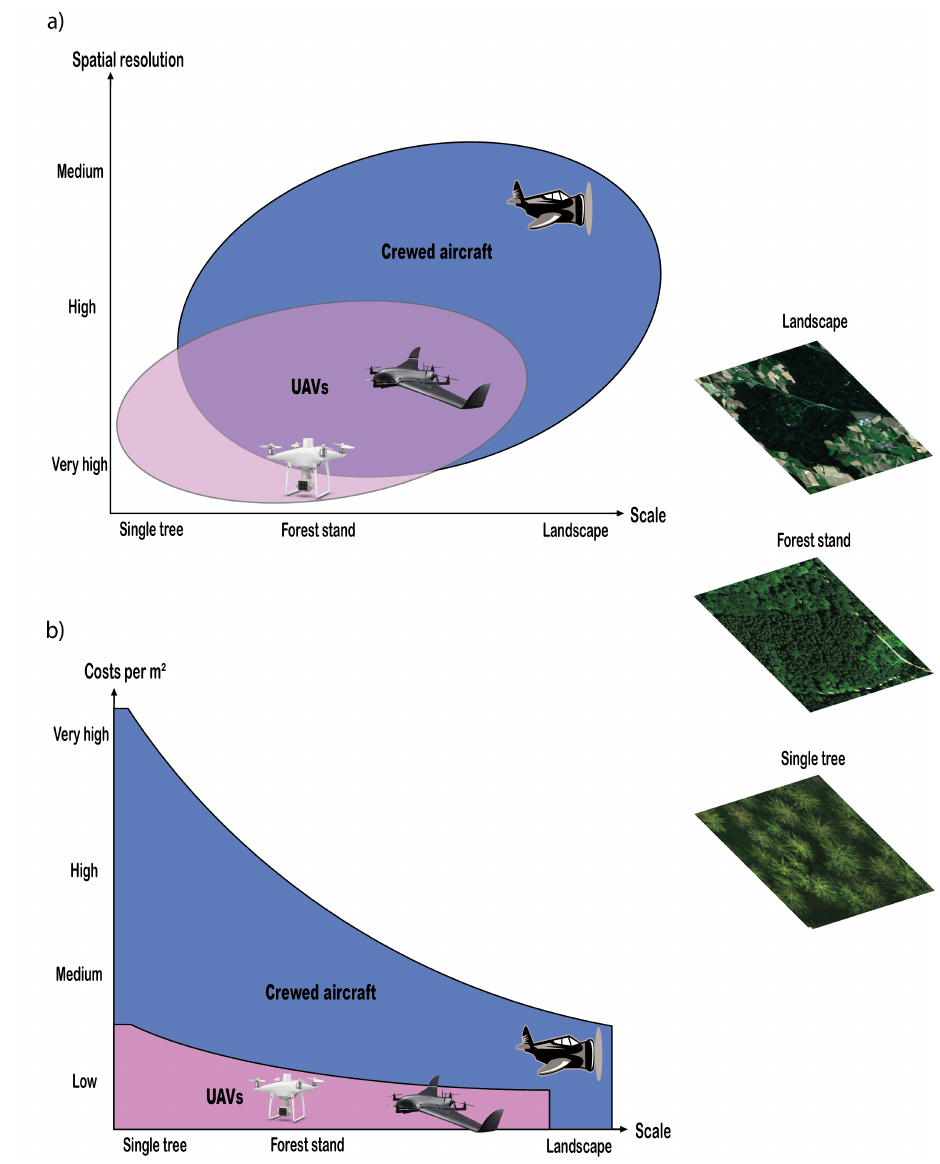
Figure 1. Abstraction of the distribution of potentially beneficial use cases of crewed aircraft and different UAV types used for remote sensing in forestry: ( a ) by scale and spatial resolution, ( b ) by scale and costs per m². Note: within the overlap area in the top graph, UAVs often have a significant cost advantage over crewed aircraft and are faster and more frequently deployable. Multirotor drones are easier to handle compared to fixed-wing aircraft, but are only suitable for relatively small